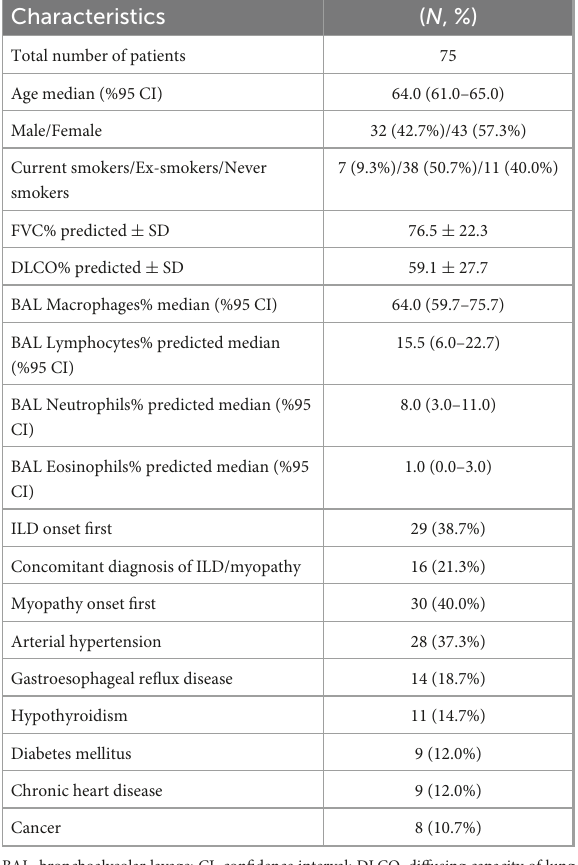
TABLE 1 Baseline characteristics. TABLE 2 Most frequently encountered autoantibodies.